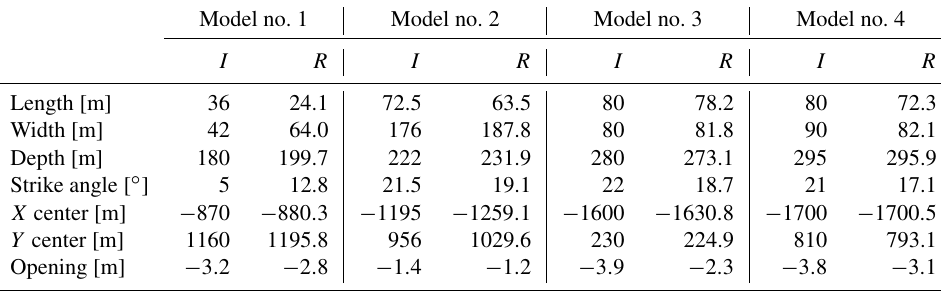
Table 3. Analytical model parameters used in the source modeling. I refers to initial values and R to refined values; coordinates are given in a local rectangular system, shown in Fig.